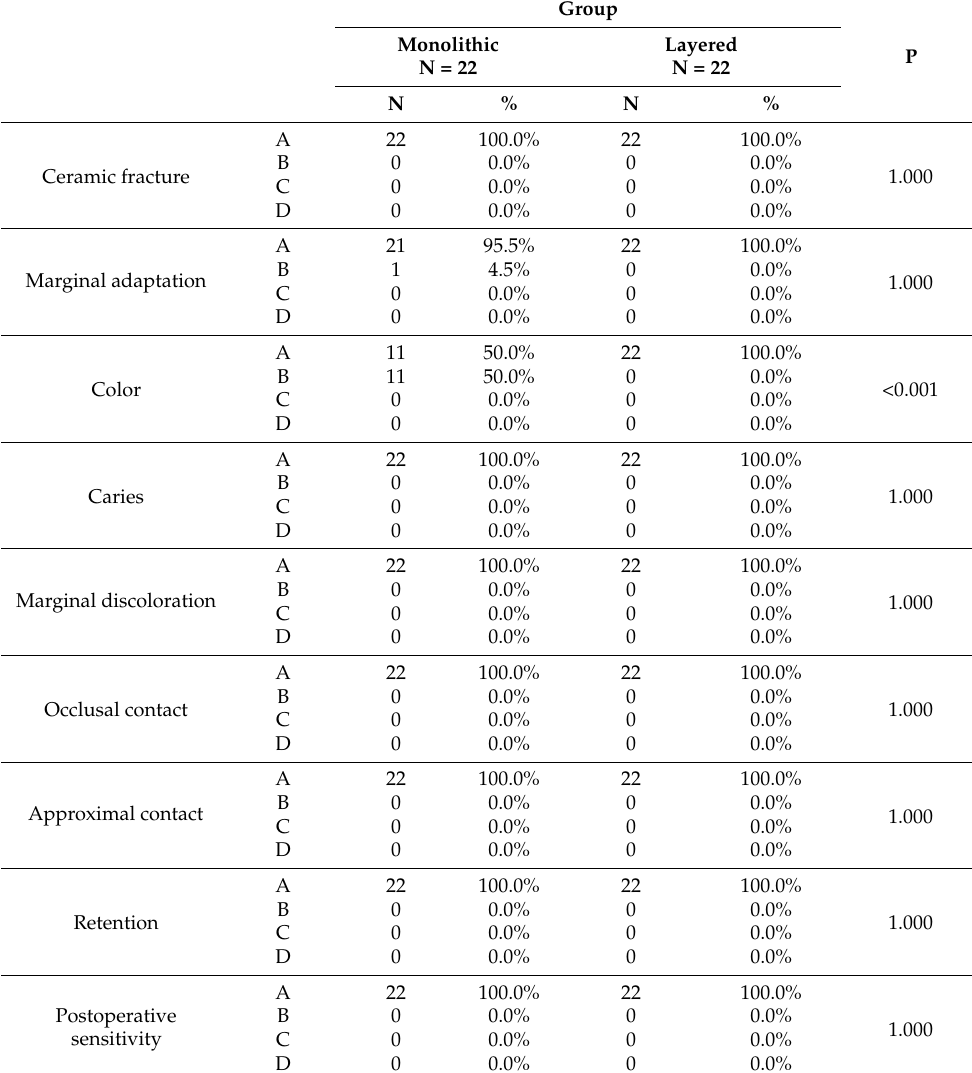
Table 3. Differences between study groups in clinical characteristics of crowns immediately after the